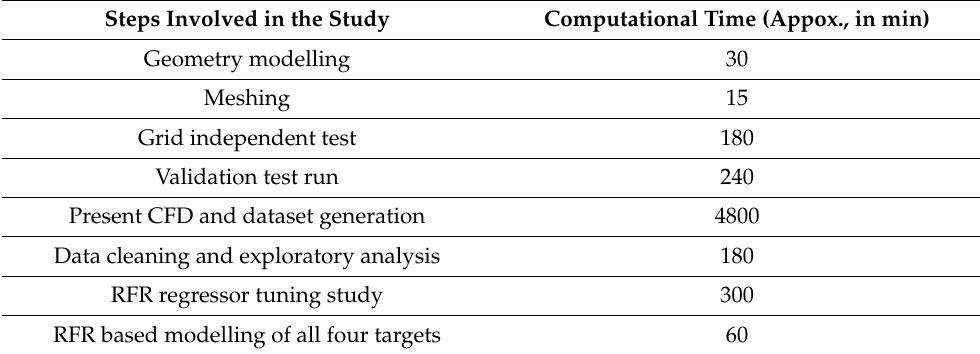
Table 2. Computational time requirements for CFD and RFR